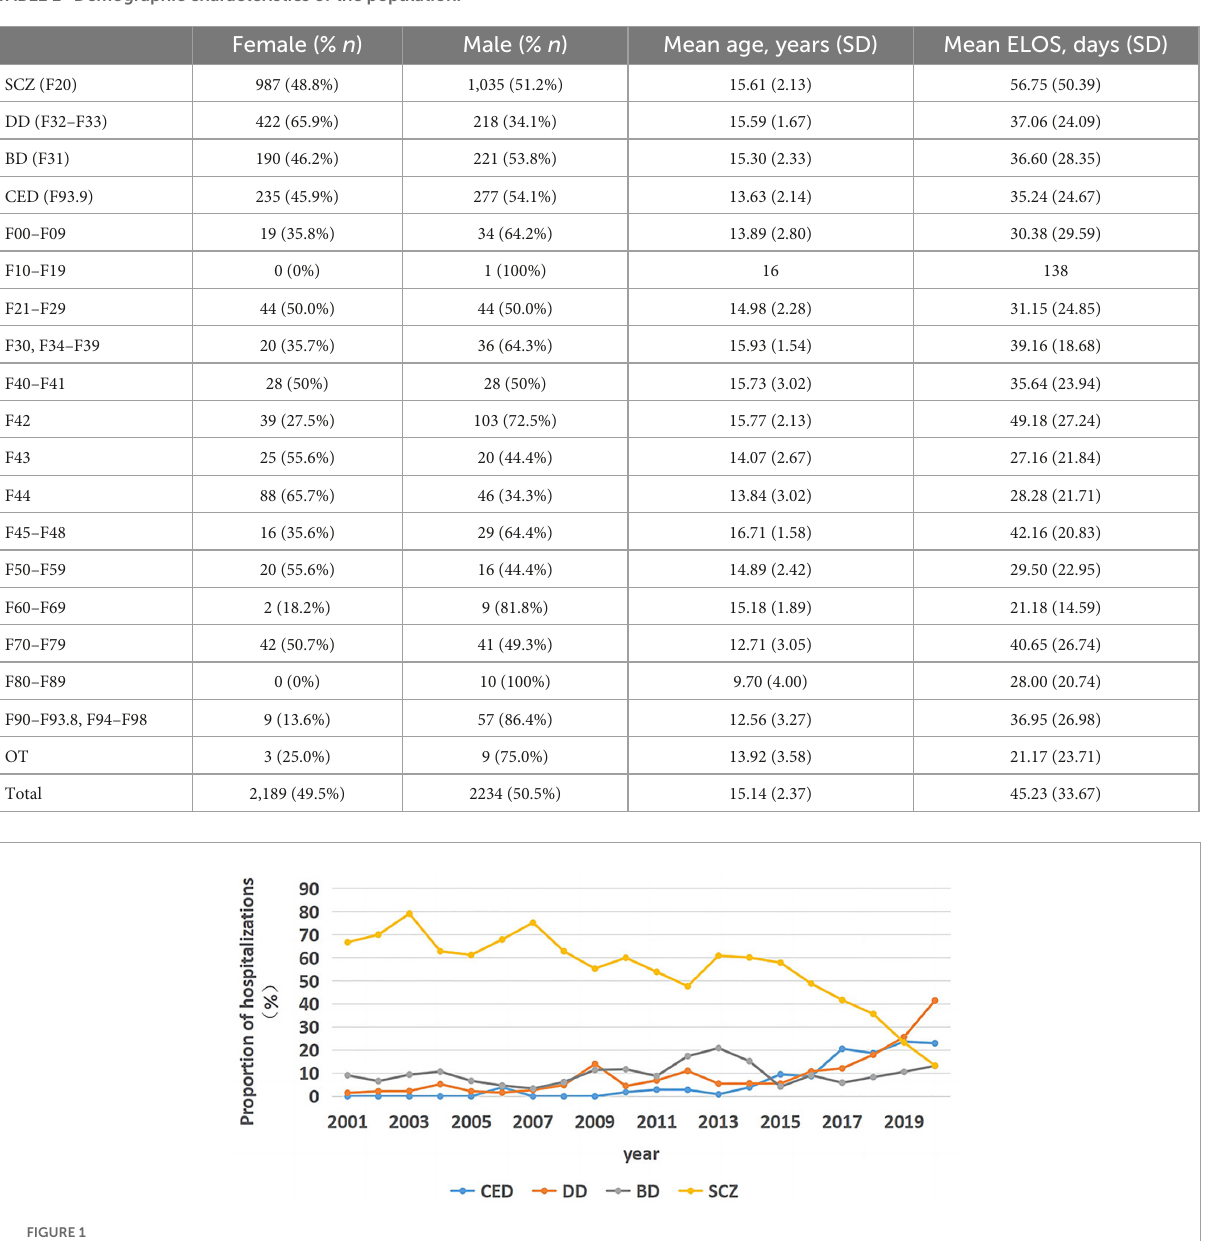
TABLE 1 Demographic characteristics of the population.